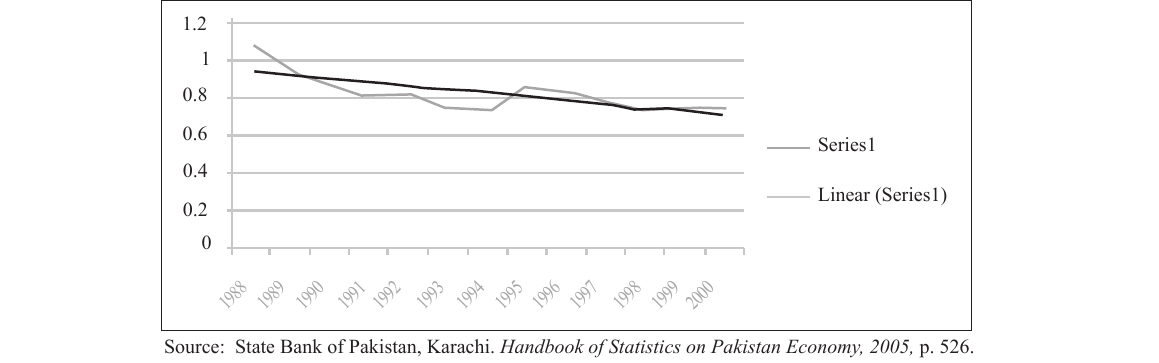
Figure 3. Expenditure on Health as % of GDP from